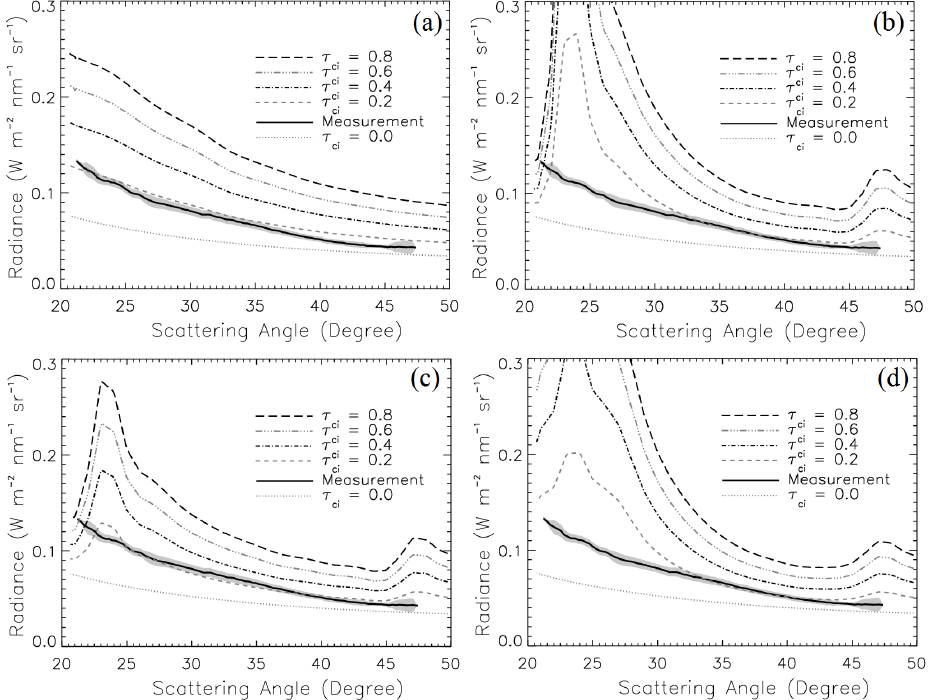
Fig. 11. Measured and simulated I ↓ as a function of scattering angles. The standard deviation of the measurement is represented by the grey shade. Measurement from 18 April 2011. The simulations were performed for different τ ci and an assumed ice crystal shape of (a) rough aggregates, (b) solid columns, (c) plates, and (d) mixture.